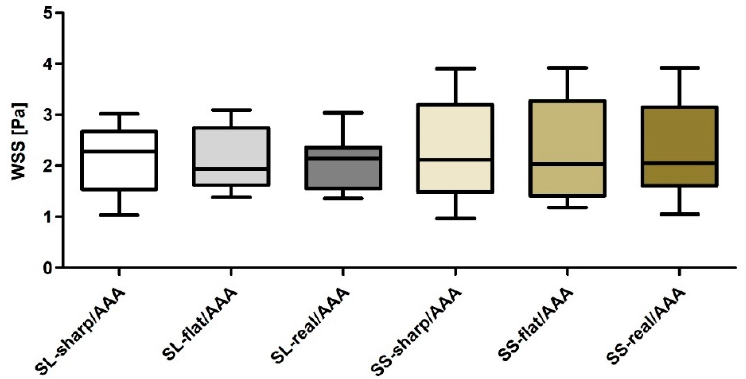
Figure 11. Bar chart representation of WSS value between aneurysm and stent ‐ graft for abdominal aortic aneurysm (AAA), long stent ‐ graft (SL), and short stent ‐ graft (SS) for sharp velocity profile, flat velocity profile, real velocity profile.